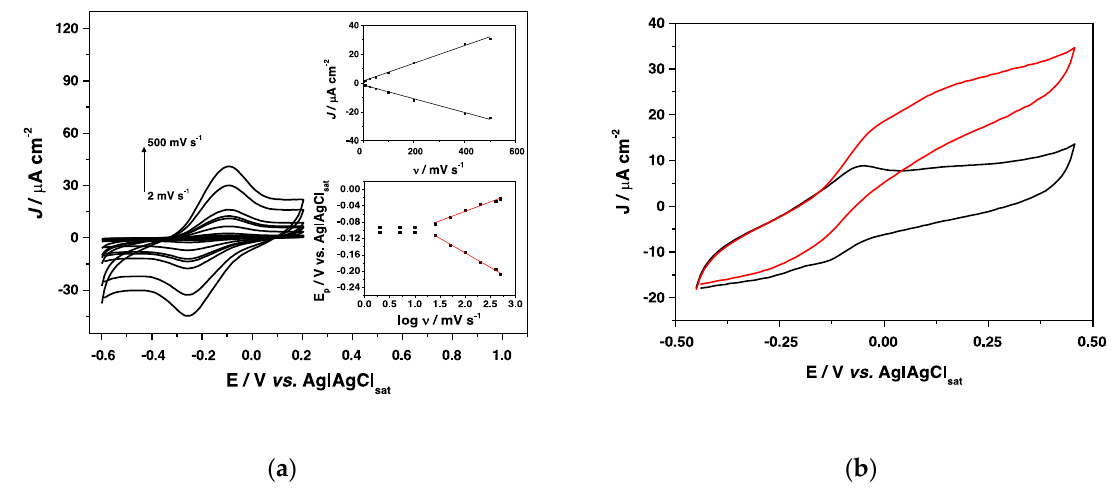
Figure 3. ( a ) CVs of Ct CDH C291Y/GA/4-APh,4-MBA/AuNPs/GC in pH 7.4, 50 mM TRIS (0.1 M KCl) in the potential range of − 0.6 V to 0.35 V, scan rates from 2 mV s − 1 to 500 mV s − 1 . Inset: linear part of cathodic ( J pc ) and anodic peak current densities ( J pa ) vs. scan rate ( v ). ( b ) CVs of Ct CDH C291Y/GA/4-APh, 4-MBA/AuNPs/GC in absence (black) and in presence of 5 mM glucose (red) in 50 mM TRIS buffer, pH 7.4 (0.1 M KCl) at a scan rate of 5 mV s − 1 . T = 25 °C.